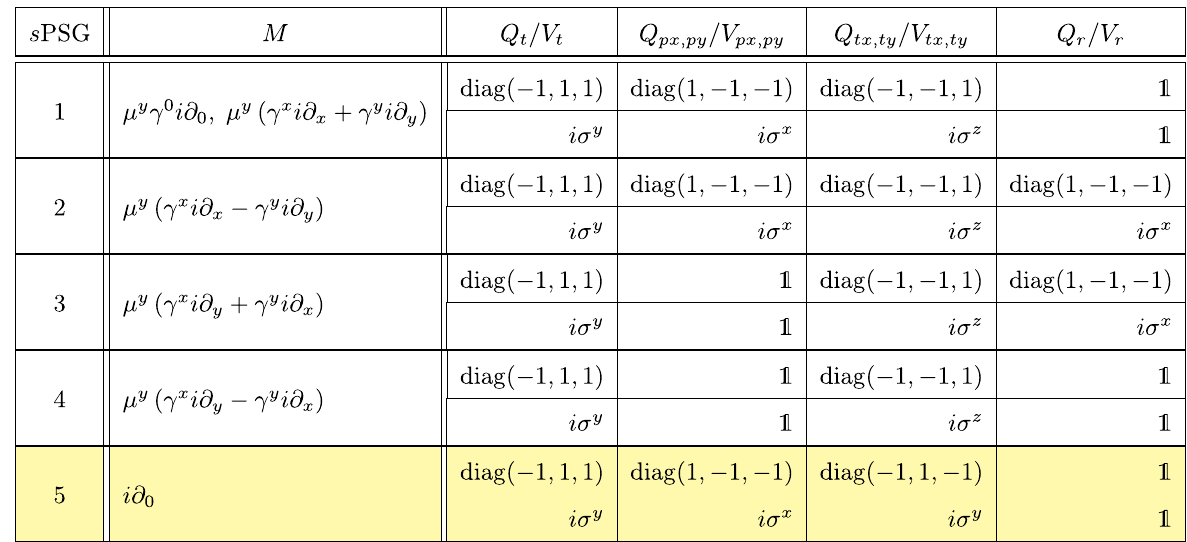
¯ X μ y X Þ . These are